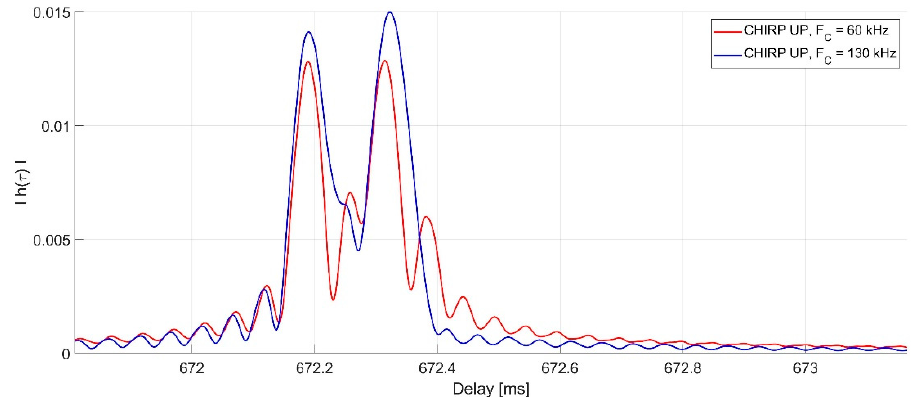
Figure 2. An example of the module of the estimate of impulse responses calculated in a simulation for two different central frequencies in shallow water for a transmitter moving at a speed of 15 m/s.